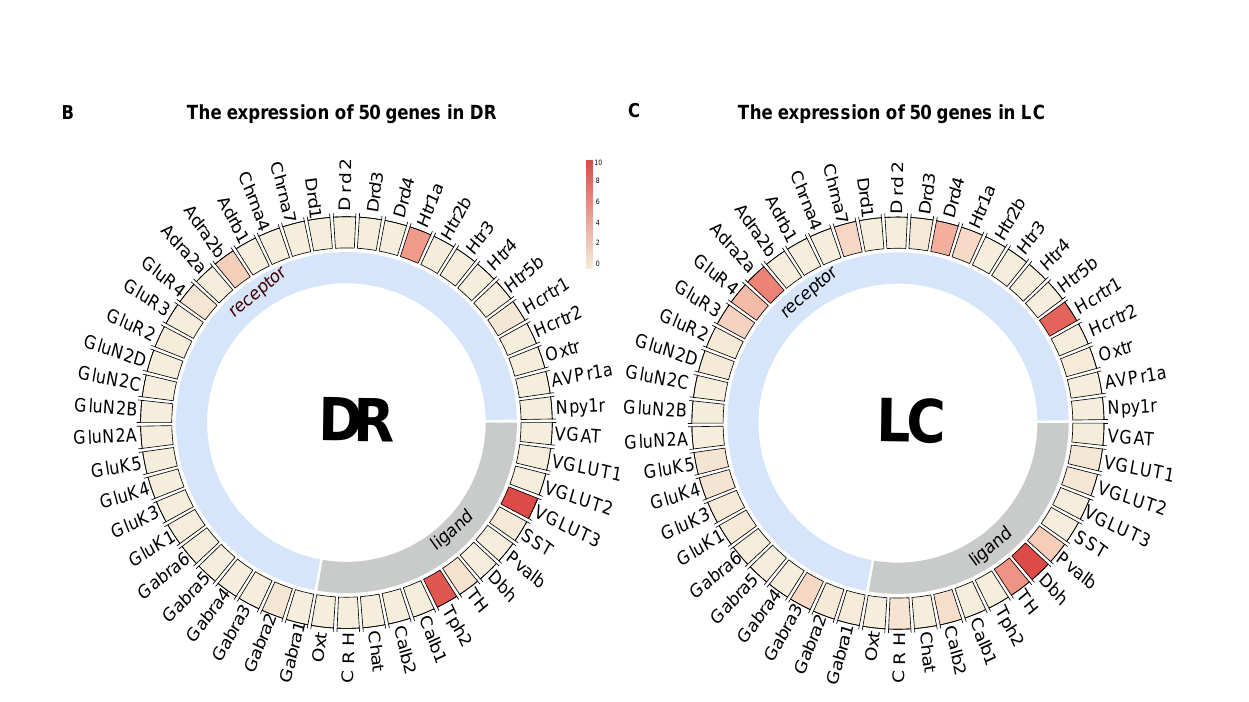
FIGURE 4 | Overall view of the chemo-connectome database. (A) Heatmap of the chemo-connectome database. (B,C) Circos diagram of neurotransmission- related gene expression in dorsal raphe (DR) and locus coeruleus (LC). The color represents the expression density.